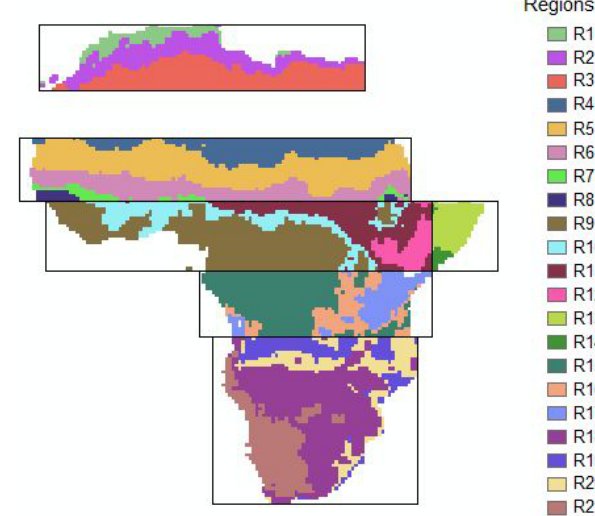
Fig. 2. Location regions in Africa based on similarity of annual pre- cipitation cycle (based on Sylla et al., 2010).